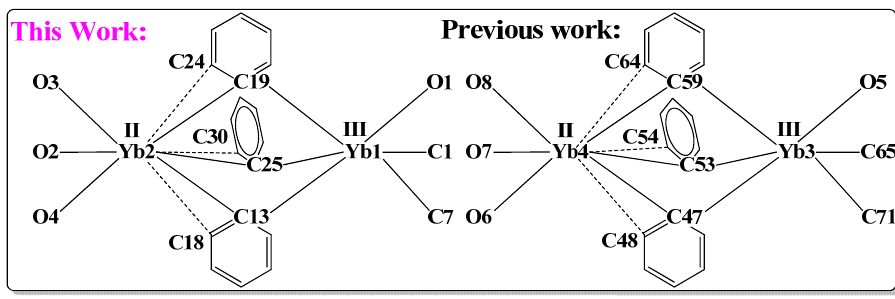
Figure 3. Comparison of the numbering of complex 3 and [Yb 2 Ph 5 (thf) 4 ] [39]. Table 1. Selected bond lengths of complex 3 and the reported structure of [Yb 2 Ph 5 (thf) 4 ].